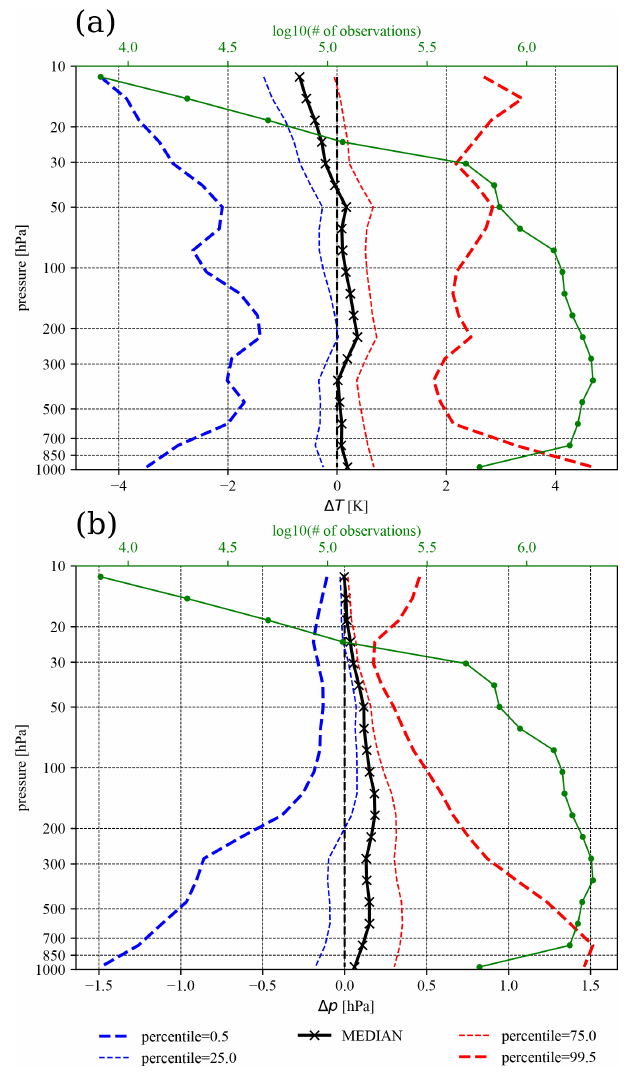
Figure 4. The (a) temperature and (b) pressure difference statis- tics between ARPEGE and IFS produced for the same period as in Fig. 3 and with all valid data available globally along the Aeolus orbits. Temperature and pressure values are computed as in L2Bp, i.e. weighted average over the accumulation of Rayleigh-clear ob-